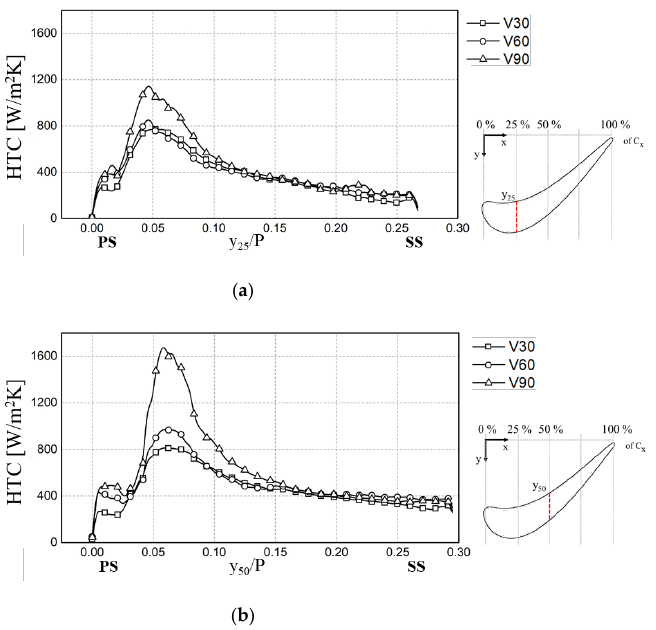
Figure 9. HTC of the plane tip in the y-direction ( a ) 25%of C x ; ( b ) 50% of C x .